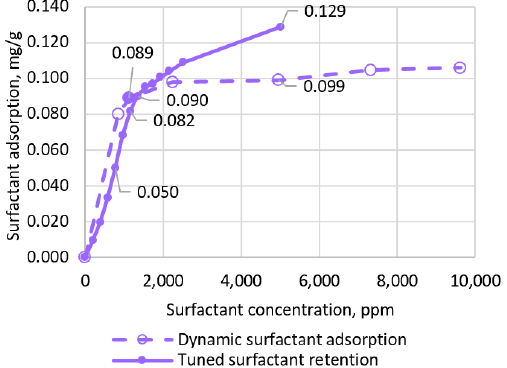
Figure 18. Surfactant retention curve obtained in the model tuning.